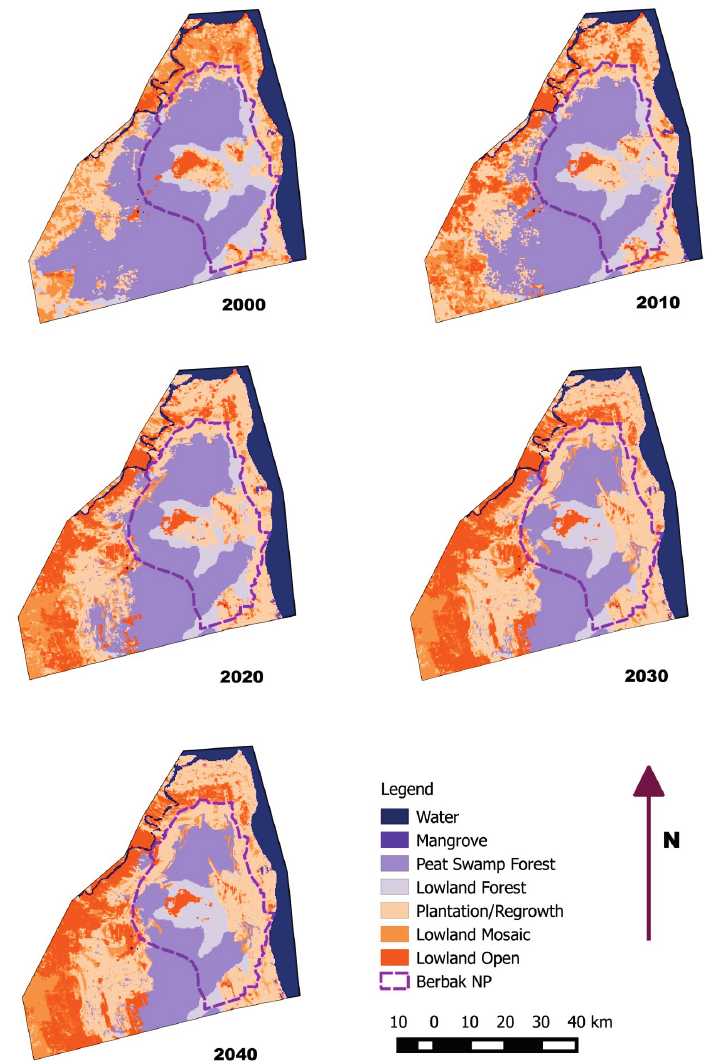
Figure 3. Land Cover Maps 2000–2040 showing land cover and extent of Berbak